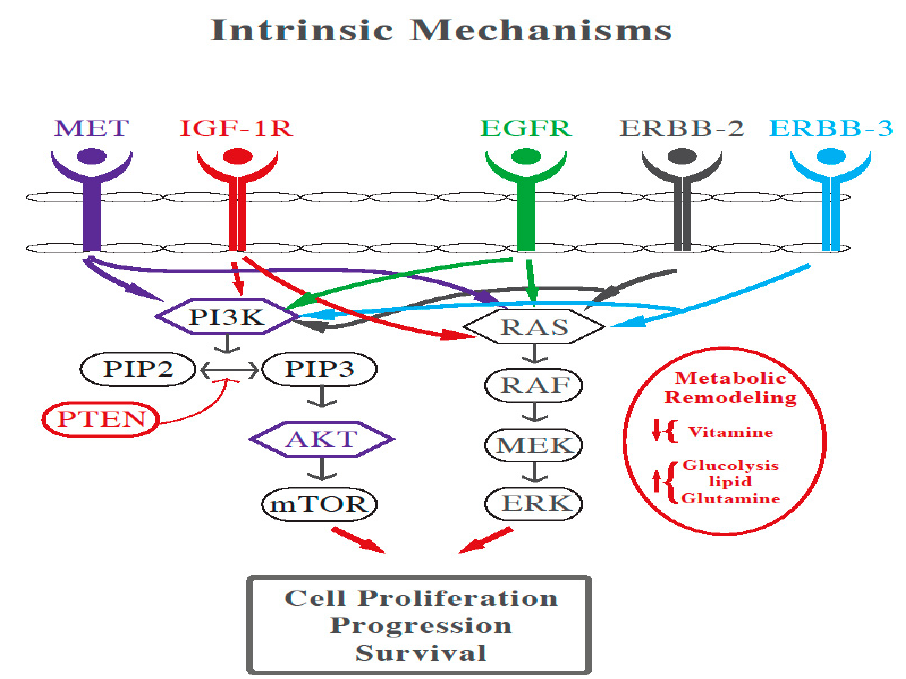
Figure 1. Cross talk between MAPK, PI3K, and Wnt pathway in